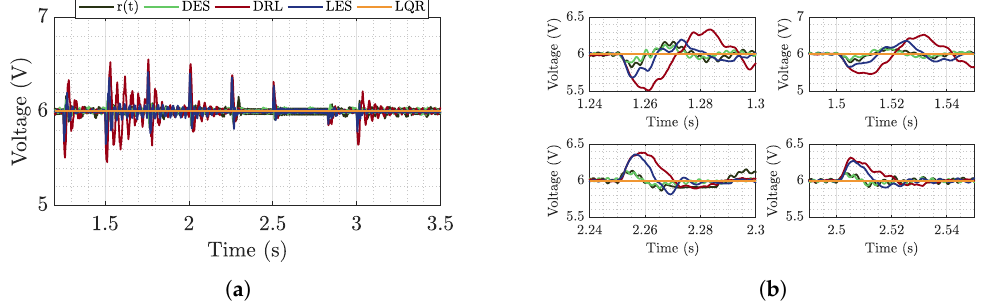
Figure 26. ( a ) Regulated voltage delivered to the DC bus. ( b ) Zoom to the oscillations caused by the power variation of the CPL boost during the simulation.